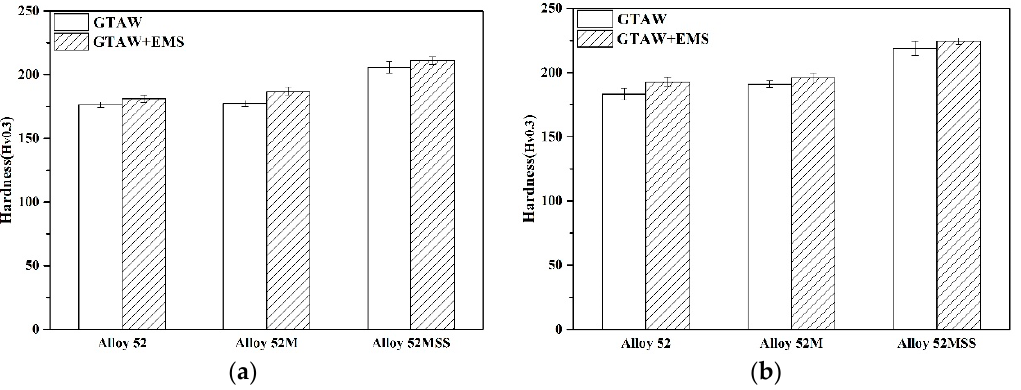
Figure 14. The average hardness measurements: ( a ) cap, and ( b ) middle region.